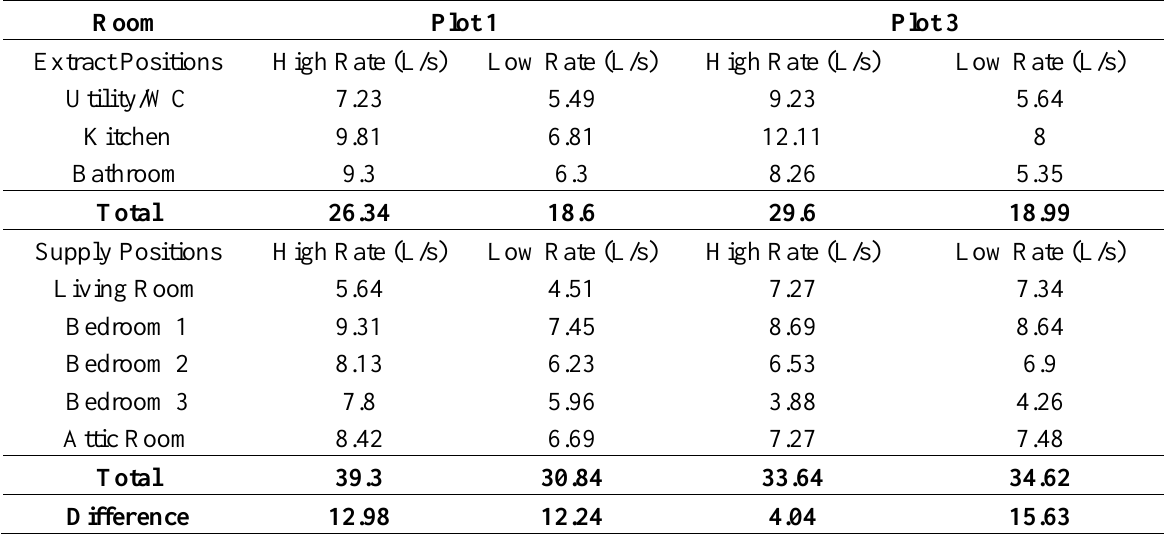
Table 3. Measured MVHR airflow